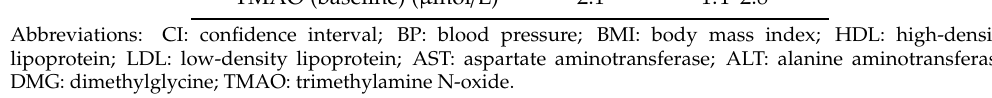
Table 2. Pharmacokinetic parameters of choline.